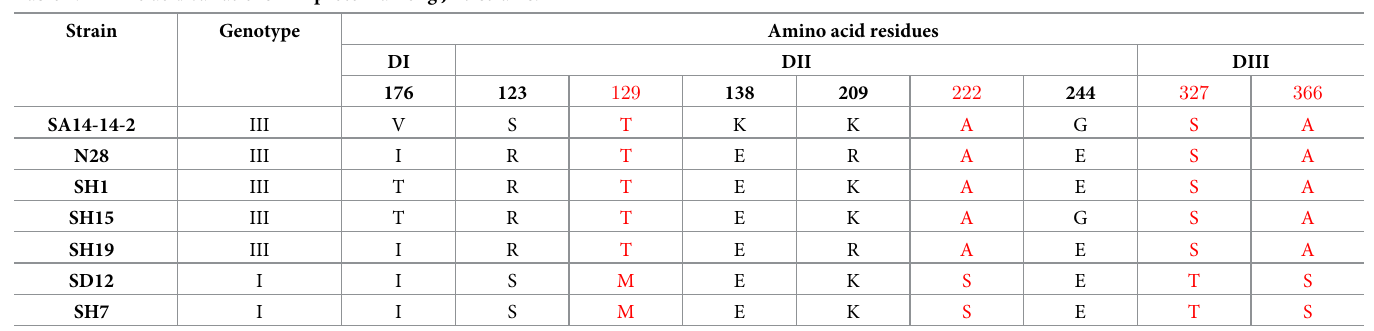
Table 1. Amino acid variations in E protein among JEV